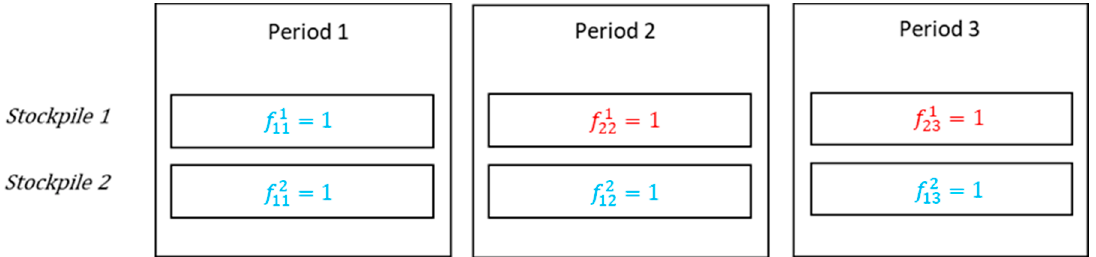
Figure 7. The values inside the boxes are the solution of the binary variables from MILP model. When product 1 is designated to stockpile, the variable is blue, otherwise, if product 2 is designated to stockpile, the variable is red.